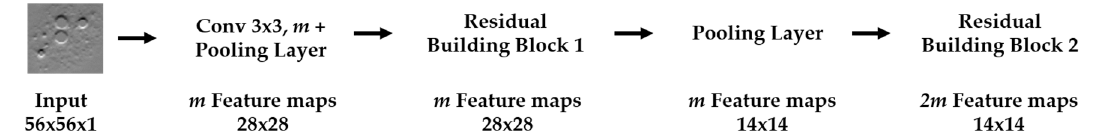
Figure 5. Structure of the four different networks.